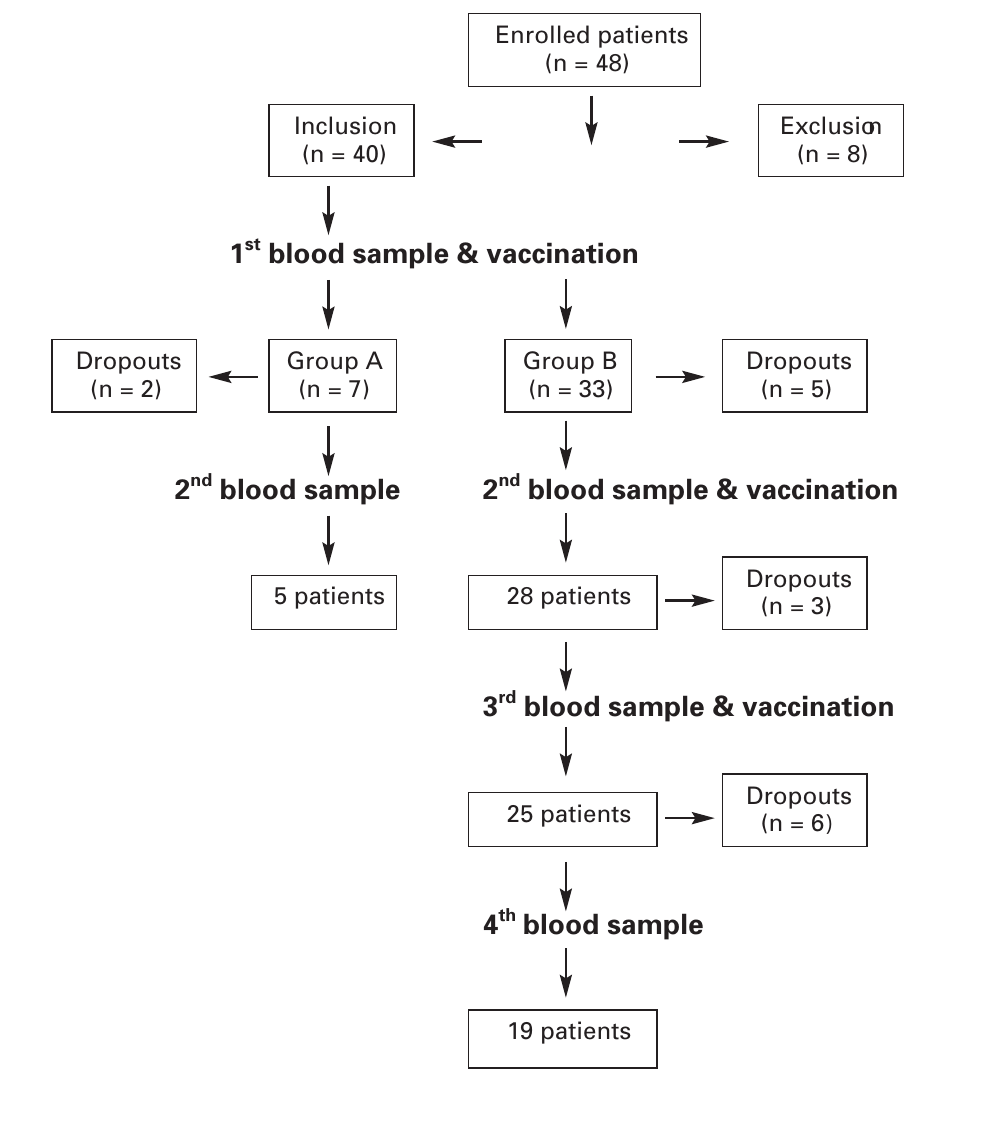
Figure 1 Patient selection in group A that is “single booster group” and group B that is “full immuni- sation